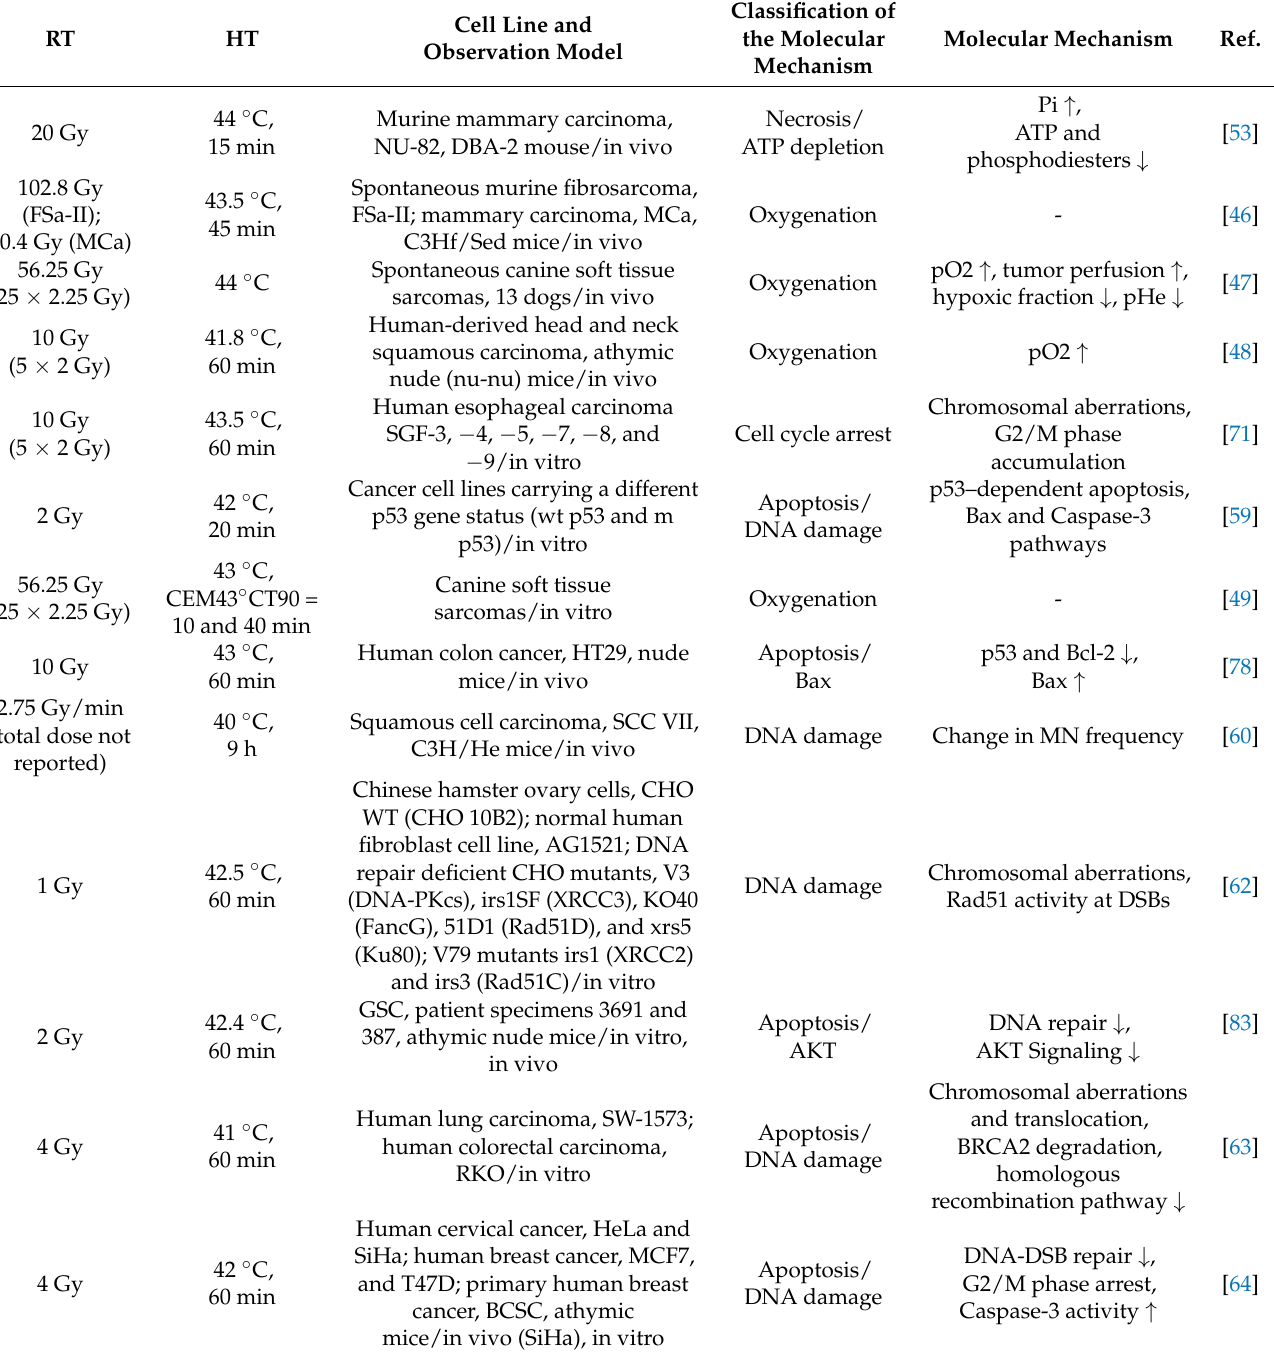
Table 2. Oxygenation, DNA damage and cell cycle arrest, induction, and regulation of